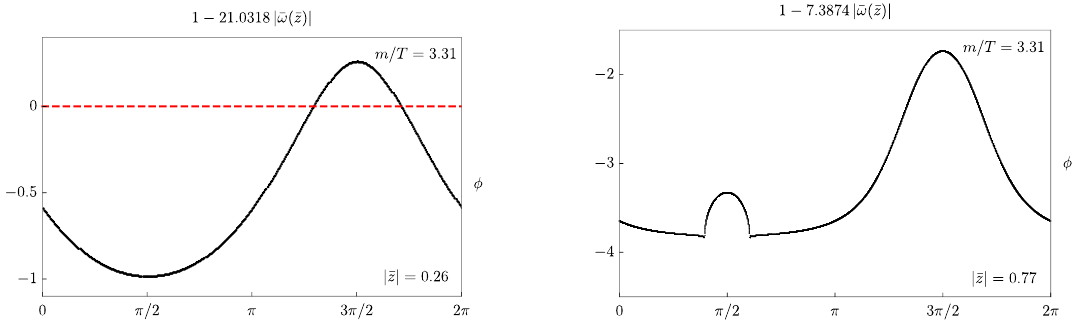
Figure 9 . A check of the sufficient condition (5.8) for the conformal bound on the speed of sound (5.5) for the transverse sound mode in Case I T ( left panel ) and the longitudinal sound mode in Case I L ( right panel ). The black line indicates the value of the function (5.9) with respect to the argument of z , i.e., φ ∈ [0 , 2 π ] , specified for the relevant parameters above each plot. Every φ where the function crosses a zero (plotted with a red dashed line) is one φ 0 in eq. (5.9). Therefore, we can see that the transverse mode depicted on the left panel satisfies the conformal bound whereas the longitudinal mode on the right may not (and does